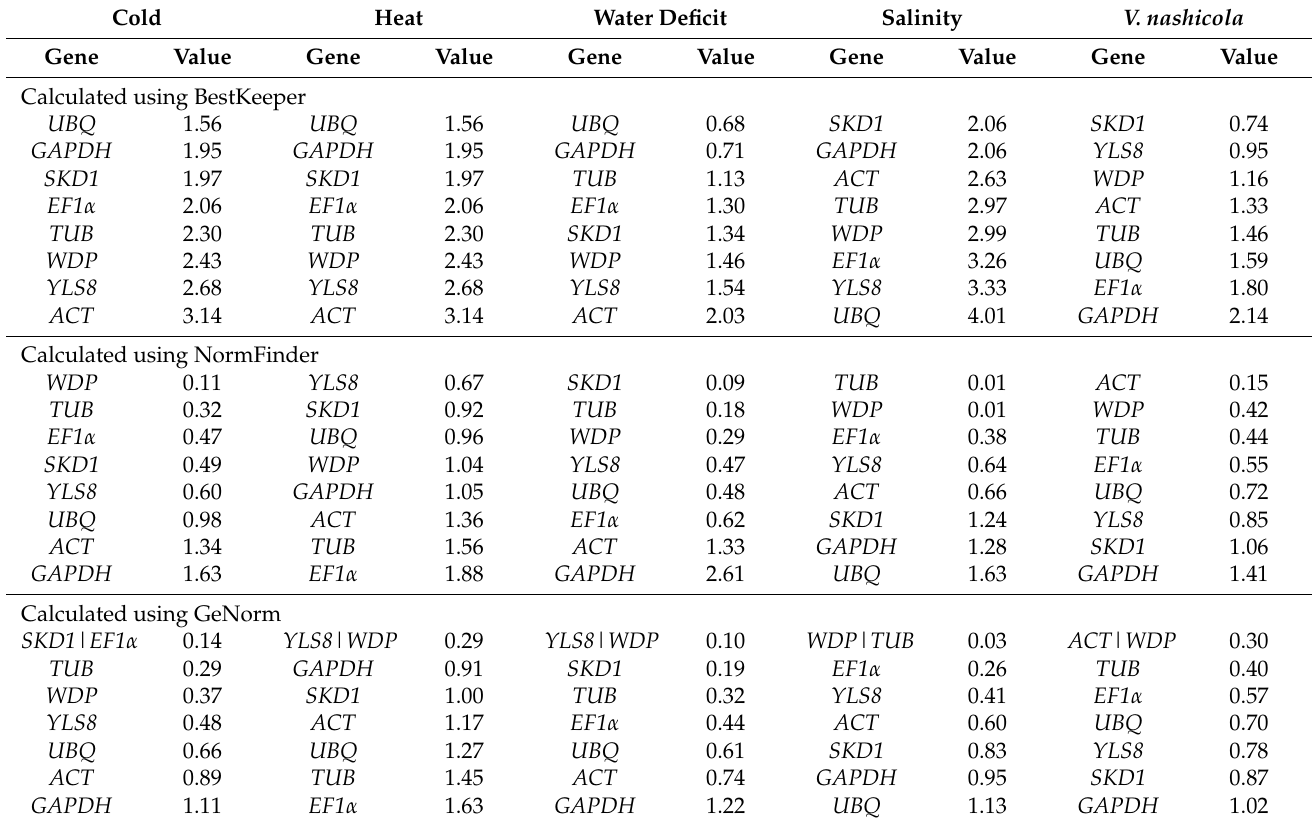
Table 4. Ranking of the expression stability of the eight candidate reference genes in pears under different abiotic and biotic stresses, with Cq values being calculated using statistical algorithm